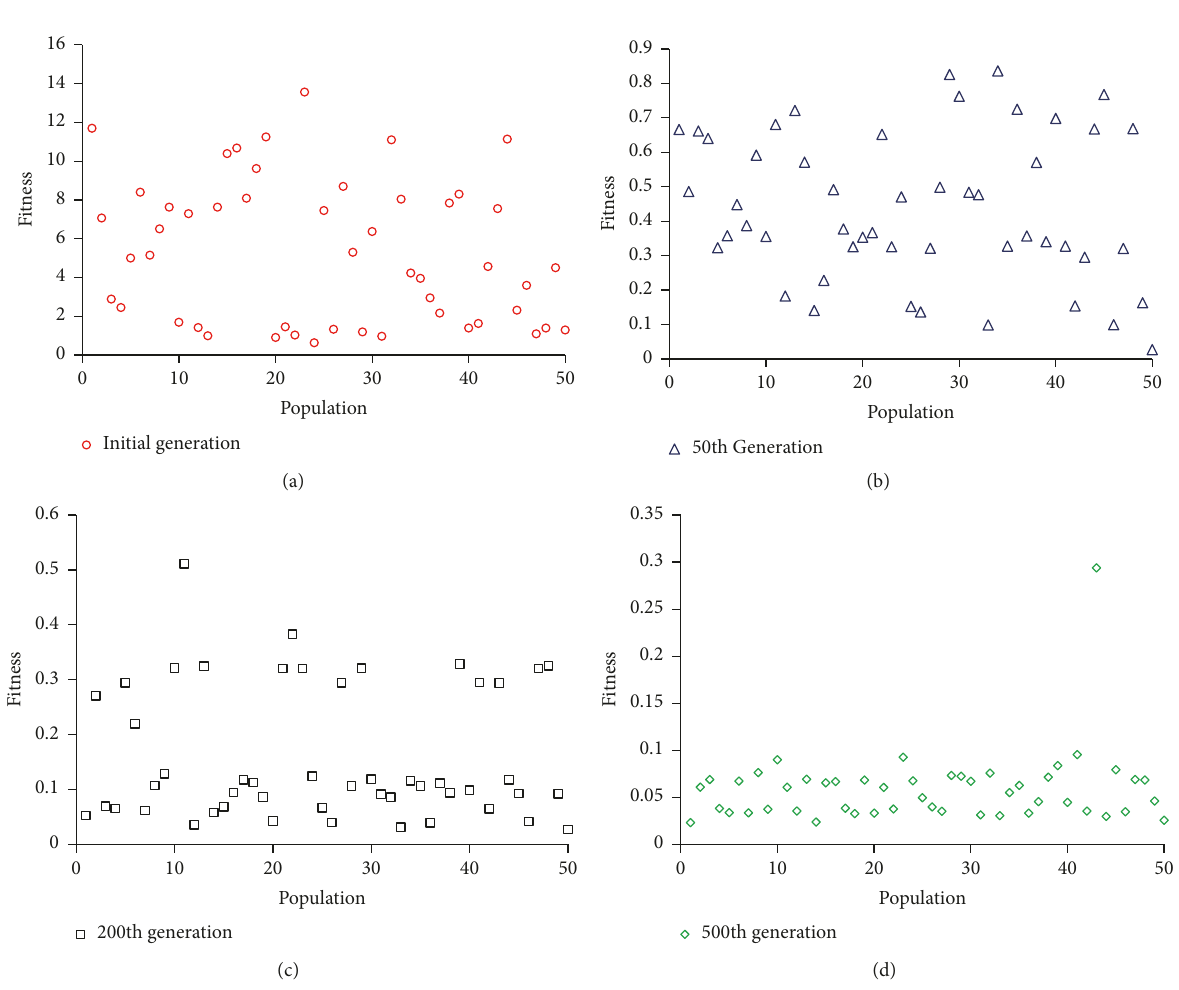
Figure 8: Fitness distribution in the searching space at different cyclic